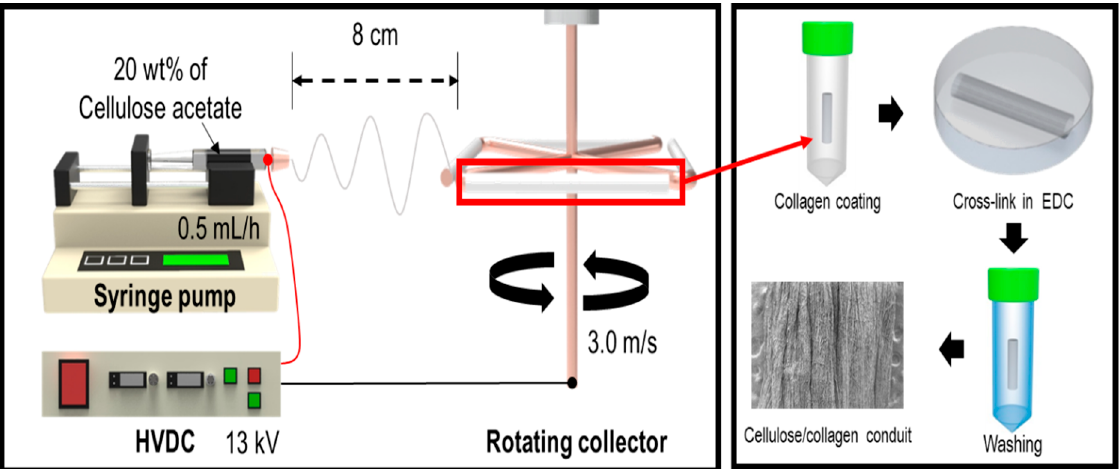
Figure 9. Fabrication schematic of cellulose/collagen nanofibrous conduit scaffold. 4.2. Scanning Electron Microscopy of the Cellulose/Collagen Nanofiber Nerve Conduit